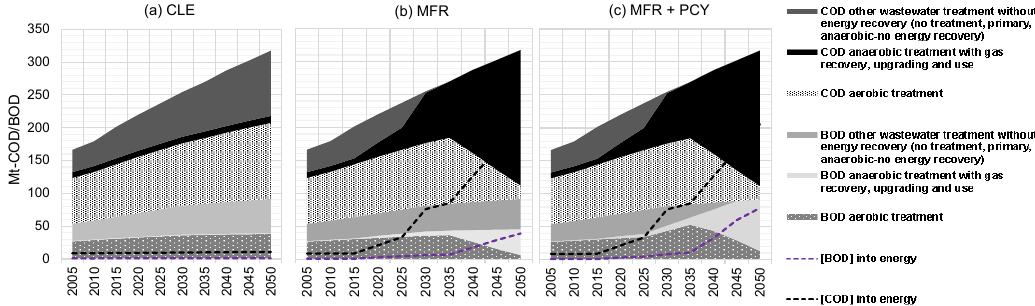
Figure 4. Global BOD (domestic) and COD (industrial) flows in wastewater by scenario.